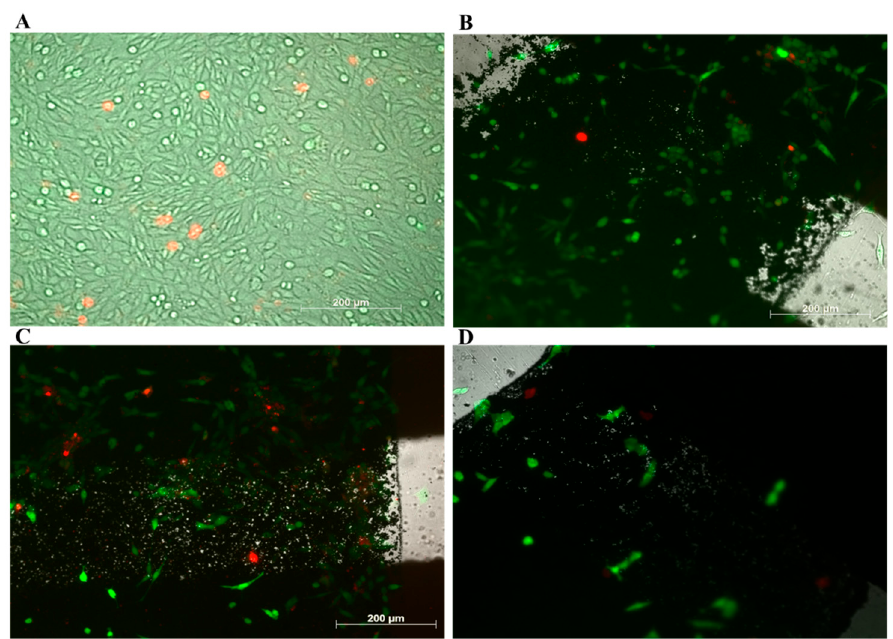
Figure 7. Cells cultured on graphene chips after 72 h of incubation. ( A ) Control well of N27 cells after 72 h at 37 °C in a 5% CO 2 atmosphere. ( B – D ) After 72 h of incubation, the cells expanded across a gap with a length of 290 µm.